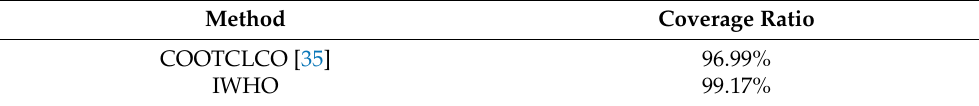
Table 10. Comparison of TABC and IWHO experimental results.